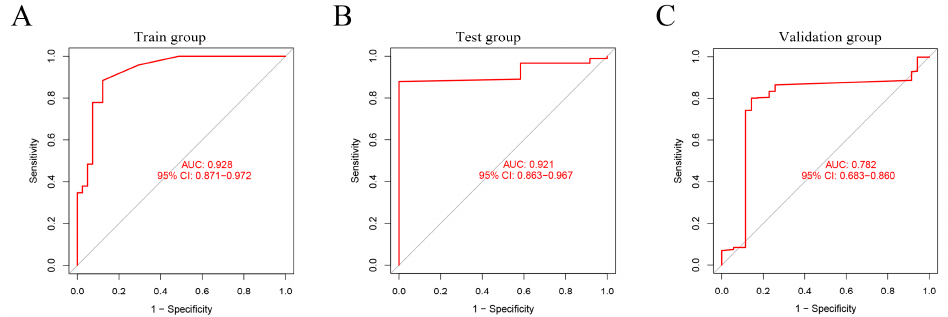
Figure 5. ROC curves of the three groups. ( A ) Training group. ( B ) Test group. ( C ) Validation